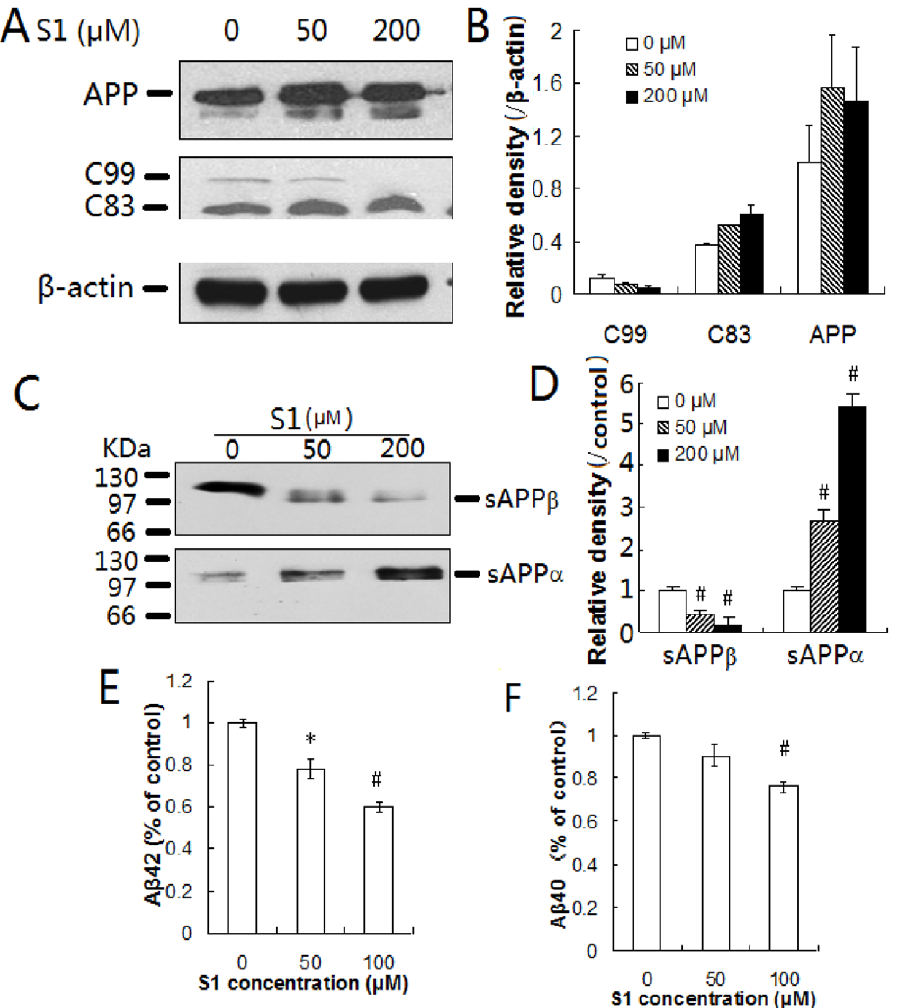
Figure 5. Effect of S1 on APP cleavage and A b production in the cells. (A) 7PA2 cells were treated with S1 at 50 and 200 m M for 24 h. Cell lysates were analyzed by Western-blot using antibodies specific for APP, C83, and C99. b -actin in all lysates was used as a loading control. (B) Quantification of APP, C99 and C83 immunoblots in (A) by densitometric analysis. The amount of APP, C99 and C83 in the cells treated with or without S1 is expressed as a value relative to b -actin. (C) sAPP a and sAPP b in the cell culture media were analyzed by Western-blot using 6E10 and anti-sAPP b antibody, respectively. (D) The intensity of protein bands in (C) was quantified. Densitometry values are expressed as values relative to buffer control samples. (E–F) Amounts of A b 40 (E) and A b 42 (F) in the cell lysates were detected by sandwich ELISA using A b 40 and A b 42 immunoassay kits (compared with cell controls, *, P , 0.05; # , P , 0.01).